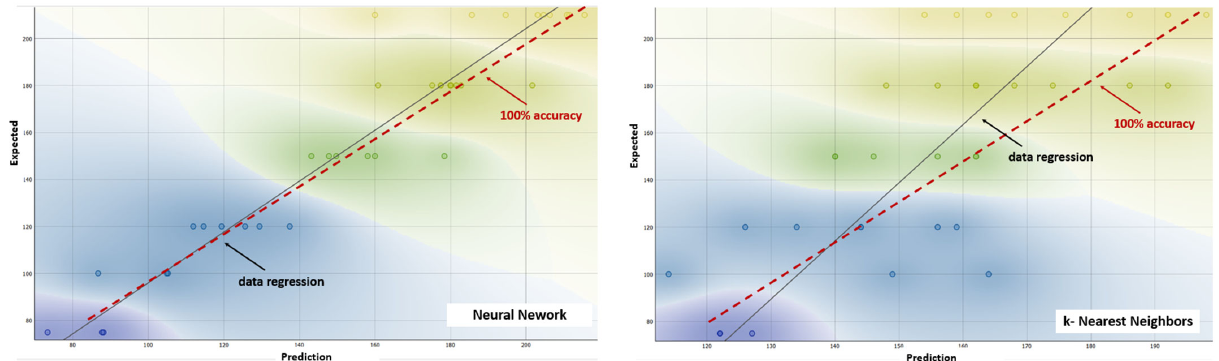
Figure 14. Predicted vs. expected values in the case of learners with best/worst accuracy (i.e., NN and k ‐ NN, respectively).